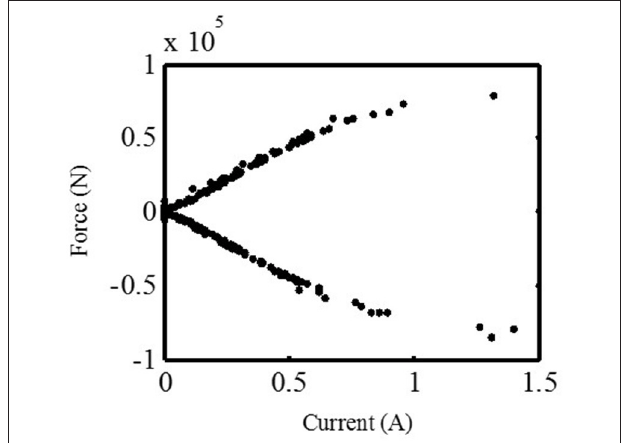
FIGURE 9 | Control currents vs. forces of the MR damper of the 5th floor PSO control structure (El-Centrol).